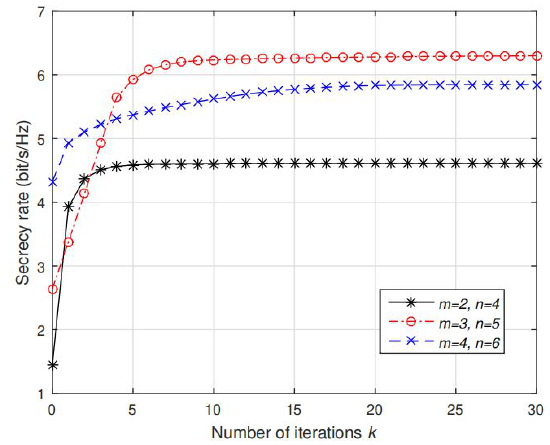
Figure 9. Convergence of C s ( R k , K k ) in Algorithm 4 as function of iteration k under different settings of m , n